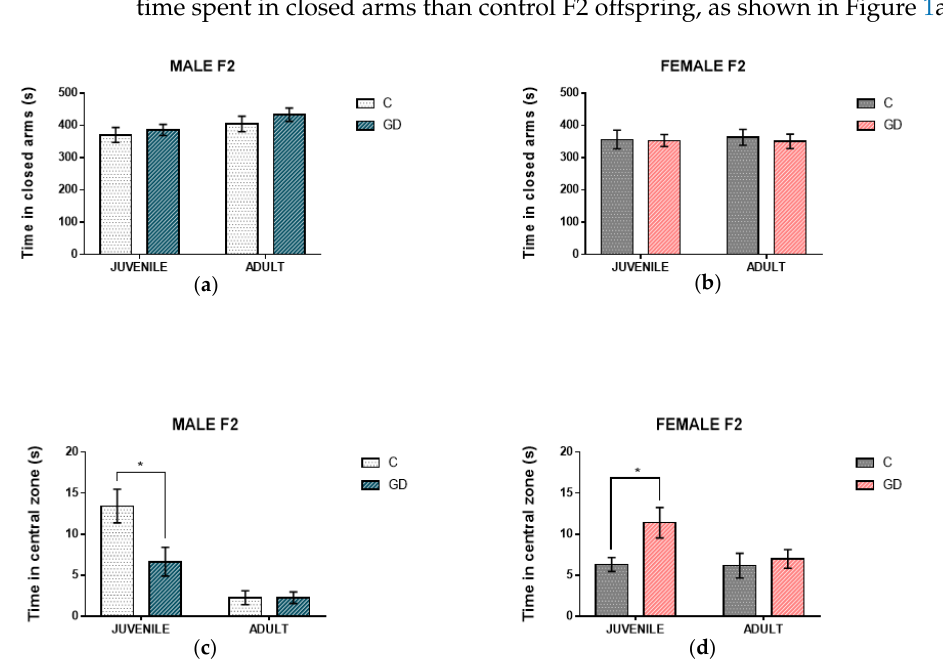
Table 1. Second-generation offspring body weight at different ages .